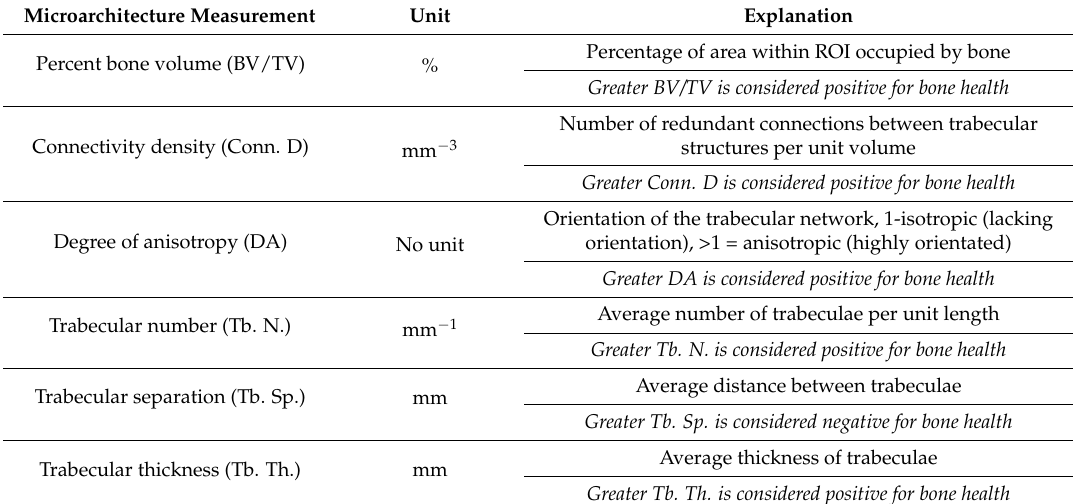
Table 2. Summary of trabecular microarchitecture outcomes measured by µ CT.